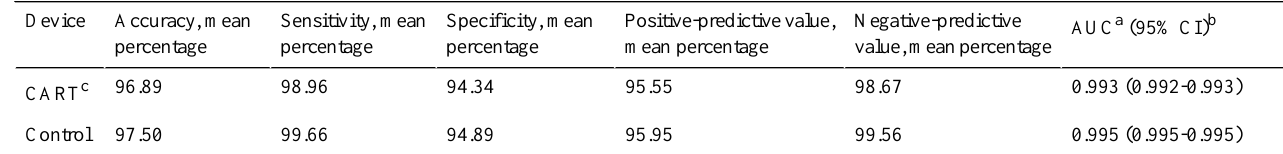
Table 4. Comparison of diagnostic performance between CardioTracker and the conventional pulse oximeter at the fingertip